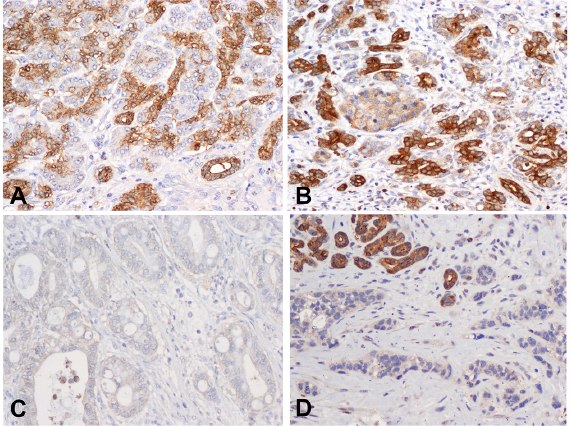
Fig 1. Expression of MAP4K5 in non-neoplastic pancreas and pancreatic ductal adenocarcinoma samples. Representative micrographs show the expression of MAP4K5 in normal pancreatic tissue (A) and chronic pancreatitis (B). The benign pancreatic ductal cells in normal pancreas and chronic pancreatitis show strong cytoplasmic staining for MAP4K5. The adjacent pancreatic acinar cells and pancreatic islet cells are either negative or have very low expression of MAP4K5. C & D, Representative micrographs show the loss of MAP4K5 expression in two different pancreatic ductal adenocarcinoma samples. Strong cytoplasmic staining for MAP4K5 in benign pancreatic ductal cells in the left upper corner in D served as internal positive control. Original magnifications: 200X.